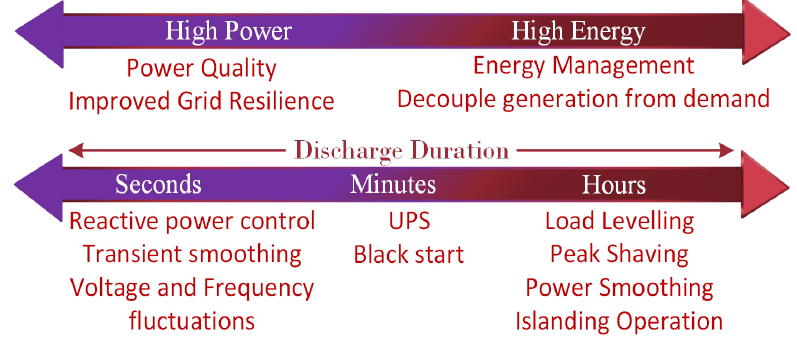
Figure 13. Energy storage applications and their discharge